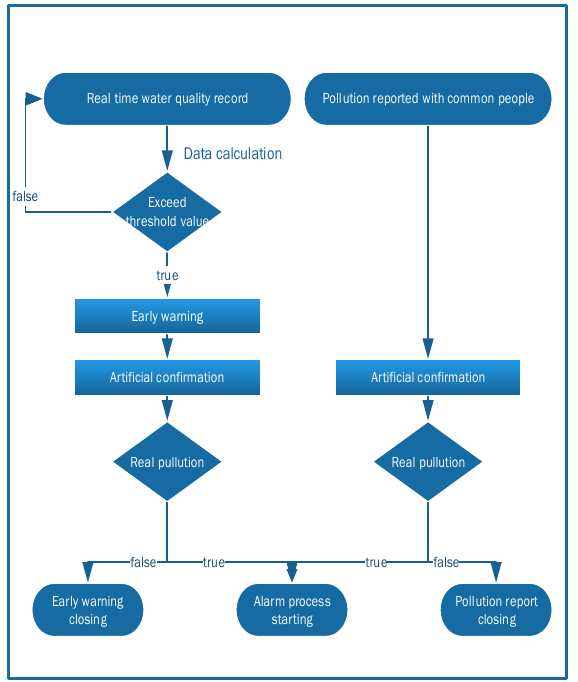
Figure 4. Workflow of pollution